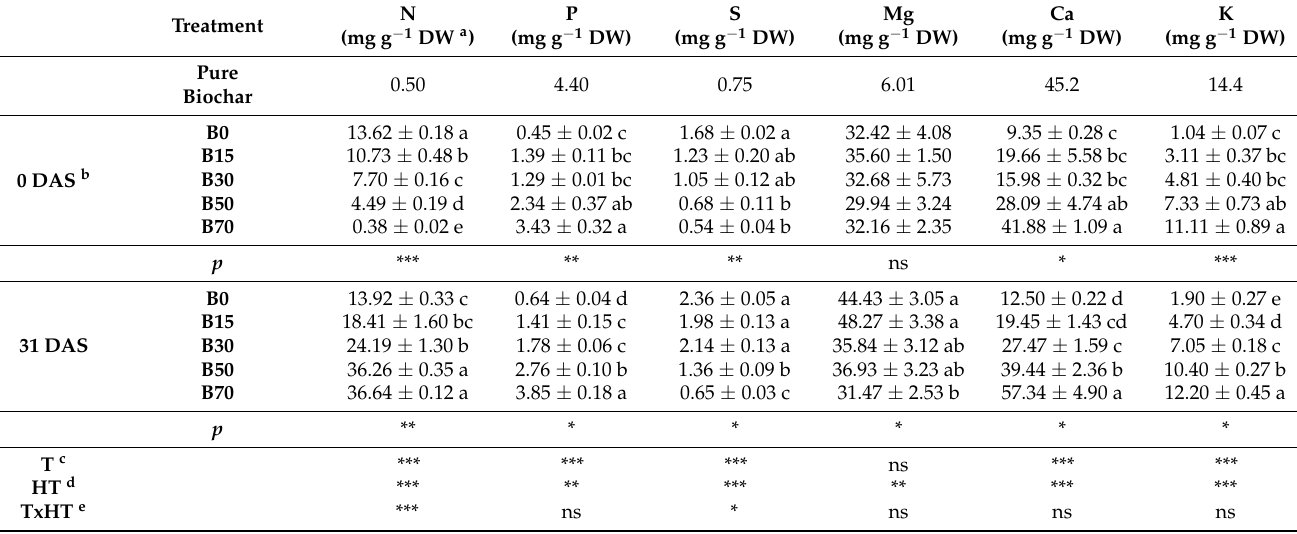
Table 3. Total content of macro-nutrients (N, P, S, Mg, Ca and K) detected in different peat:biochar substrates (Treatment: T) at the beginning (0 DAS) and the end of the experiment (31 DAS). Harvest Time (HT) is the time when substrate samples were collected at 0 and 31